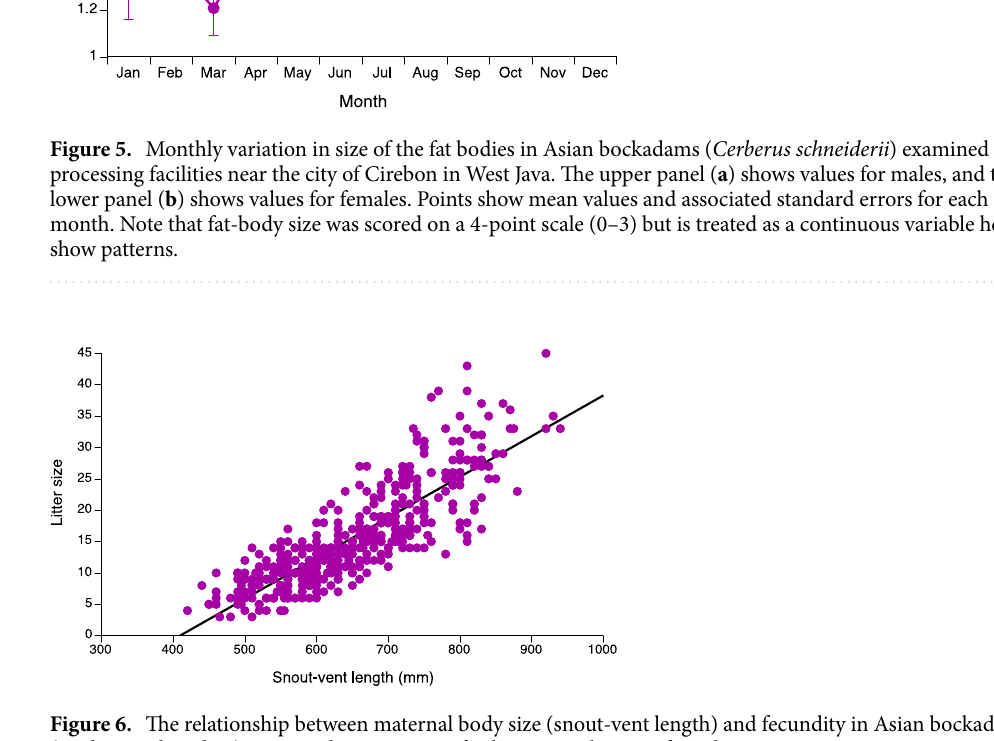
Figure 6. The relationship between maternal body size (snout-vent length) and fecundity in Asian bockadams ( Cerberus schneiderii ) examined at processing facilities near the city of Cirebon in West